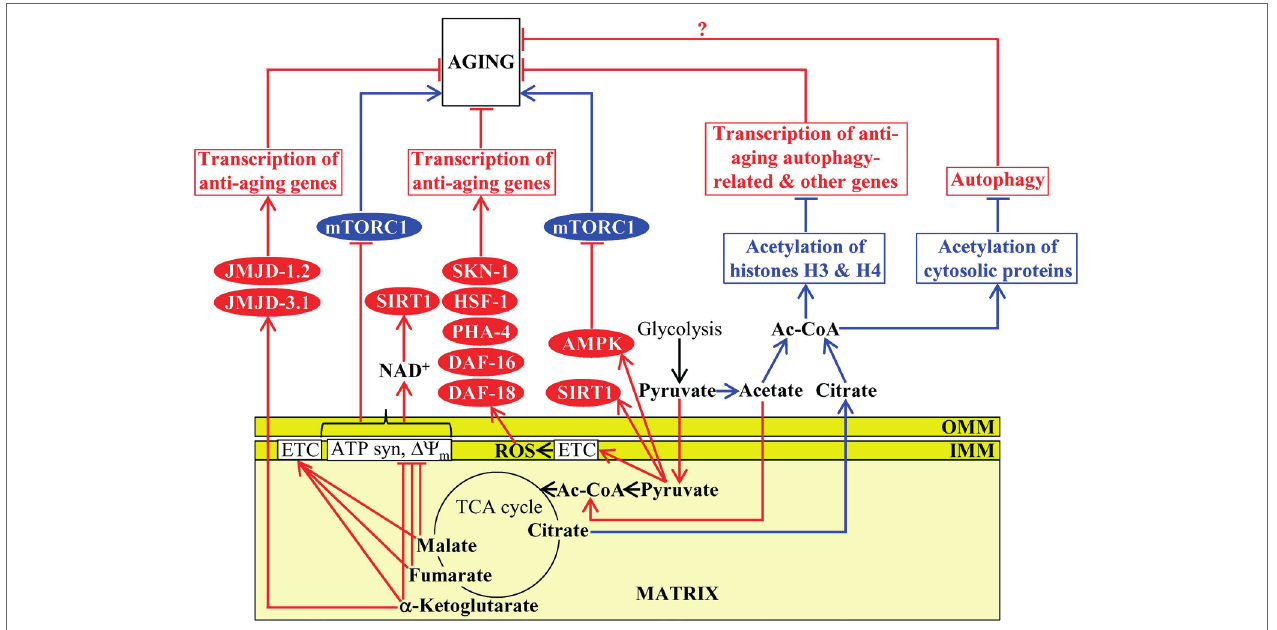
FIGURE 4 | Mitochondria contribute to aging because they affect the homeostasis of mitochondrial TCA cycle intermediates. Some mitochondrial TCA cycle intermediates regulate activities of several non-mitochondrial proteins known for their essential roles in setting up an aging-delaying cellular pattern. Activation arrows and inhibition bars denote pro-aging (displayed in blue color) or anti-aging processes (displayed in red color). Pro-aging or anti-aging proteins are displayed in blue or red color, respectively. See the text for additional details. Abbreviations: Ac-CoA, acetyl CoA; AMPK, AMP-activated protein kinase; ATP syn, ATP synthase; DAF-16, forkhead box protein O; DAF-18, phosphatidylinositol 3,4,5-trisphosphate 3-phosphatase and dual-specificity protein phosphatase; ETC, electron transport chain; HSF-1, heat shock factor 1; IMM, inner mitochondrial membrane; JMJD-1.2 and JMJD-3.1, JmjC-domain-containing histone lysine demethylases 1.2 and 3.1; mTORC1, mammalian (or mechanistic) target of rapamycin complex 1; OMM, outer mitochondrial membrane; PHA-4, defective pharyngeal development protein 4; SIRT1, sirtuin (silent mating type information regulation 2 homolog) type 1; SKN-1, skinhead-1 transcription factor; Δ Ψ m , the electrochemical potential across the inner mitochondrial